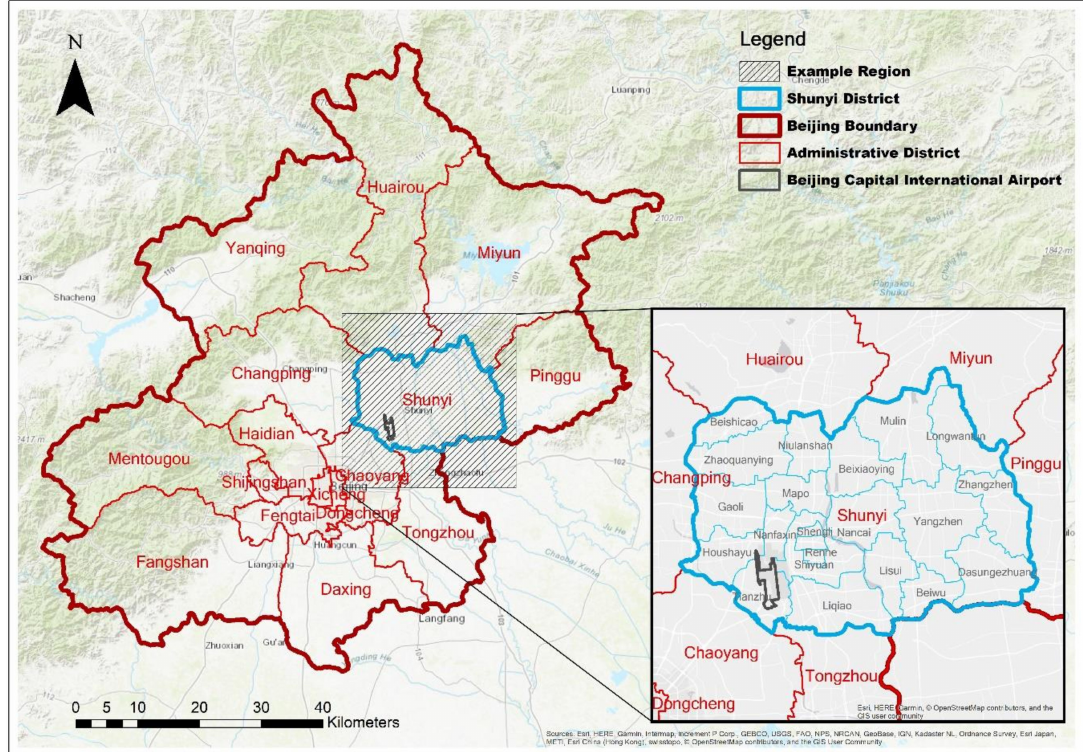
Figure 16. The location of Shunyi District and Beijing Capital International